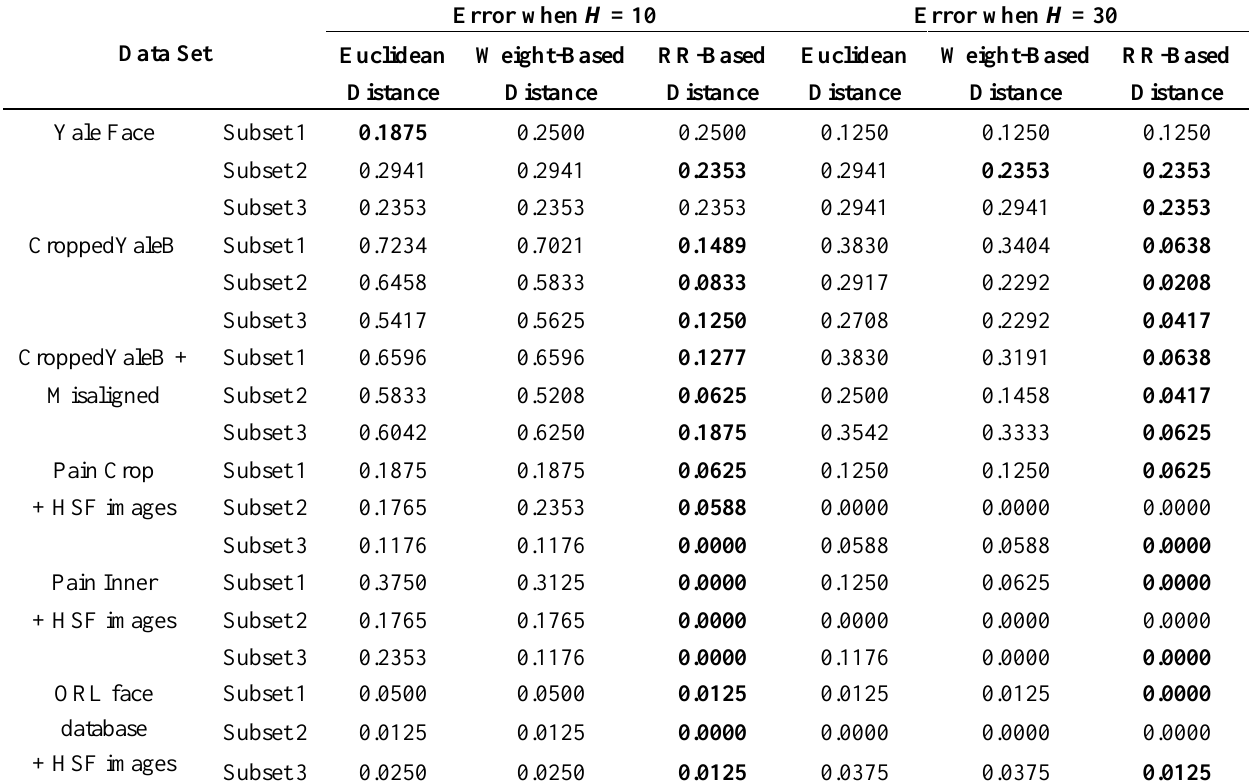
Table 3. Classification results using various distance metrics ( u = 1.0 e −7, ε = 1.0 e −6, β = 10, k =